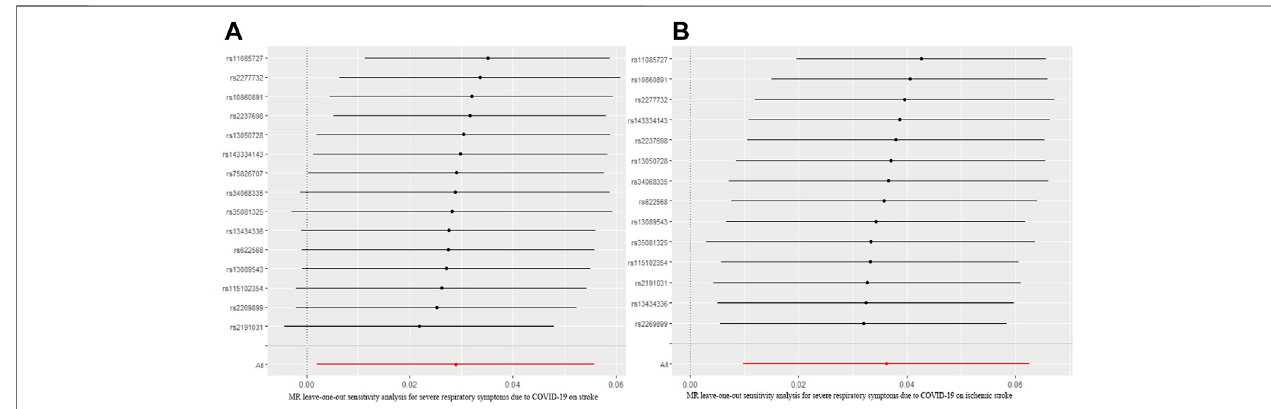
FIGURE 6 | MR leave-one-out sensitivity analysis for severe respiratory symptoms due to COVID-19 on stroke (A) and ischemic stroke (B) . MR, Mendelian randomization.